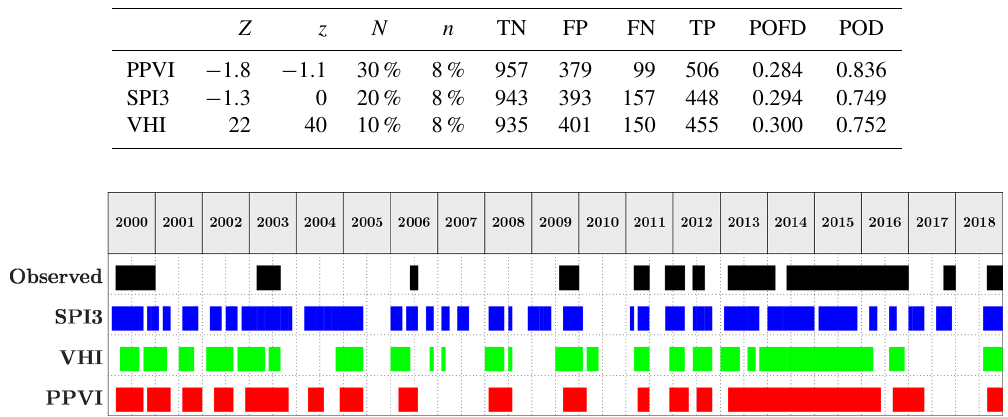
Figure 7. Comparison between observed drought events and drought events identified by the PPVI, SPI3 and VHI when calibrated with the best-performing parameters shown in Table 10. The comparison is shown for the period from 2000 to 2018.